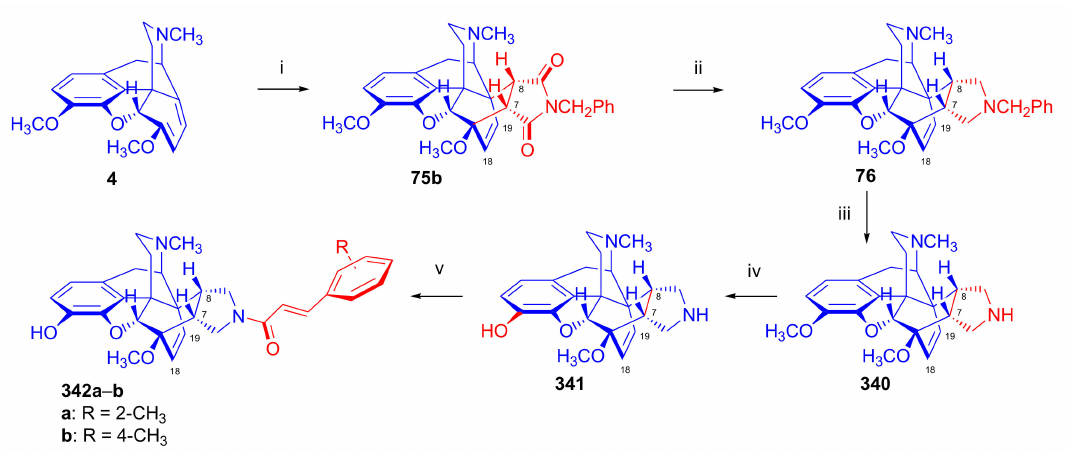
Figure 87. Synthesis of aryl substituted cinnamoyl derivatives of C 7 -C 8 -ring constrained 6,14- ethenomorphinan analogues. Reagents and conditions : (i): N -benzylmaleimide, toluene, reflux, 18 h;